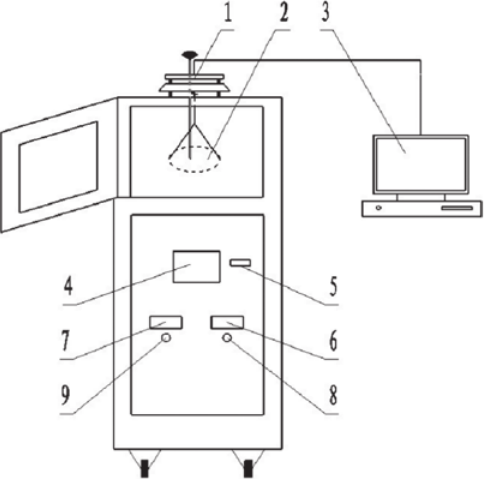
Fig. 3: Schematic diagram of microwave heating